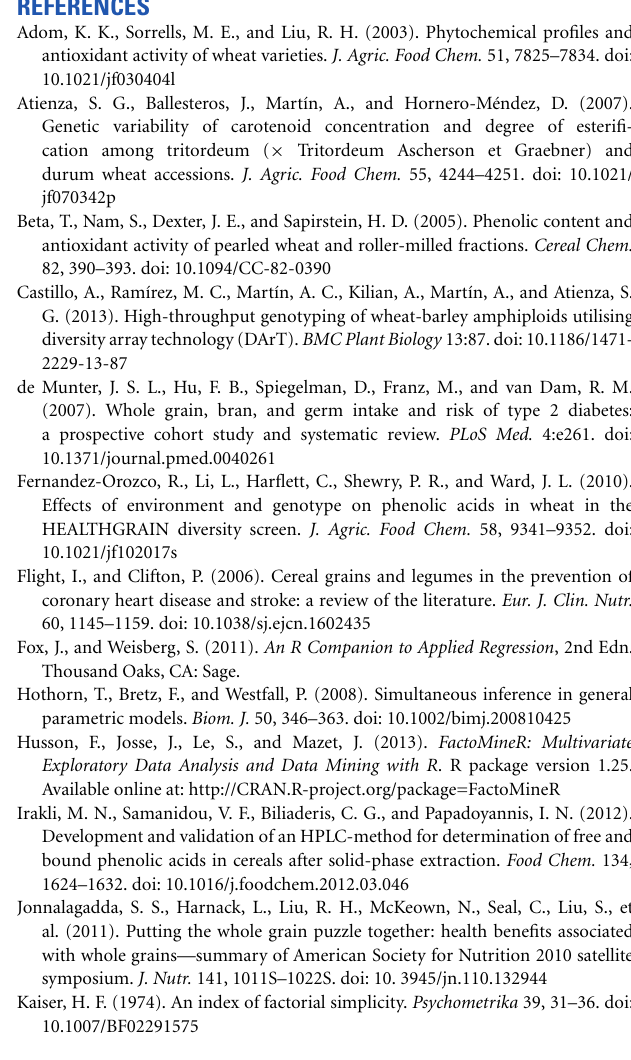
Table S1 | ANOVAs tables from the MANOVA analysis of the Model 1 (‘variable ∼ Line + Year’) and Model 2 (‘variable ∼ Year + 1RS/1BL + Substitutions + Cytoplasm + Year × 1RS/1BL + Year × Substitutions + Substitutions × Cytoplasm’). Figure S1 | RP-HPLC chromatograms of the pure phenolic compounds studied in this work. For this analysis we used pure phenolics from SIGMA-ALDRICH. Mix, a mix of the same amount of each phenolic acids. FA, ferulic acid; pCA, ρ -coumaric acid; CA, caffeic acid;VA, vanillic acid; SA, syringic acid. Figure S2 | Spectra of the pure phenolic